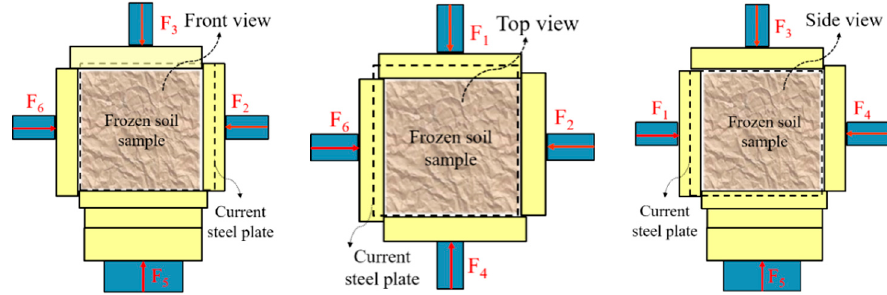
Figure 3. Three views of lapped rigid plates for frozen soil samples.